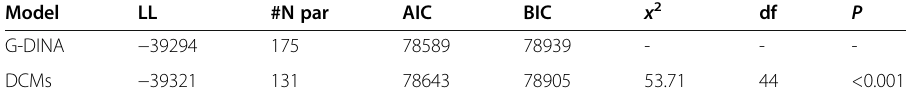
Table 10 Likelihood ratio test for the combinations of DCMs with the G-DINA model Model